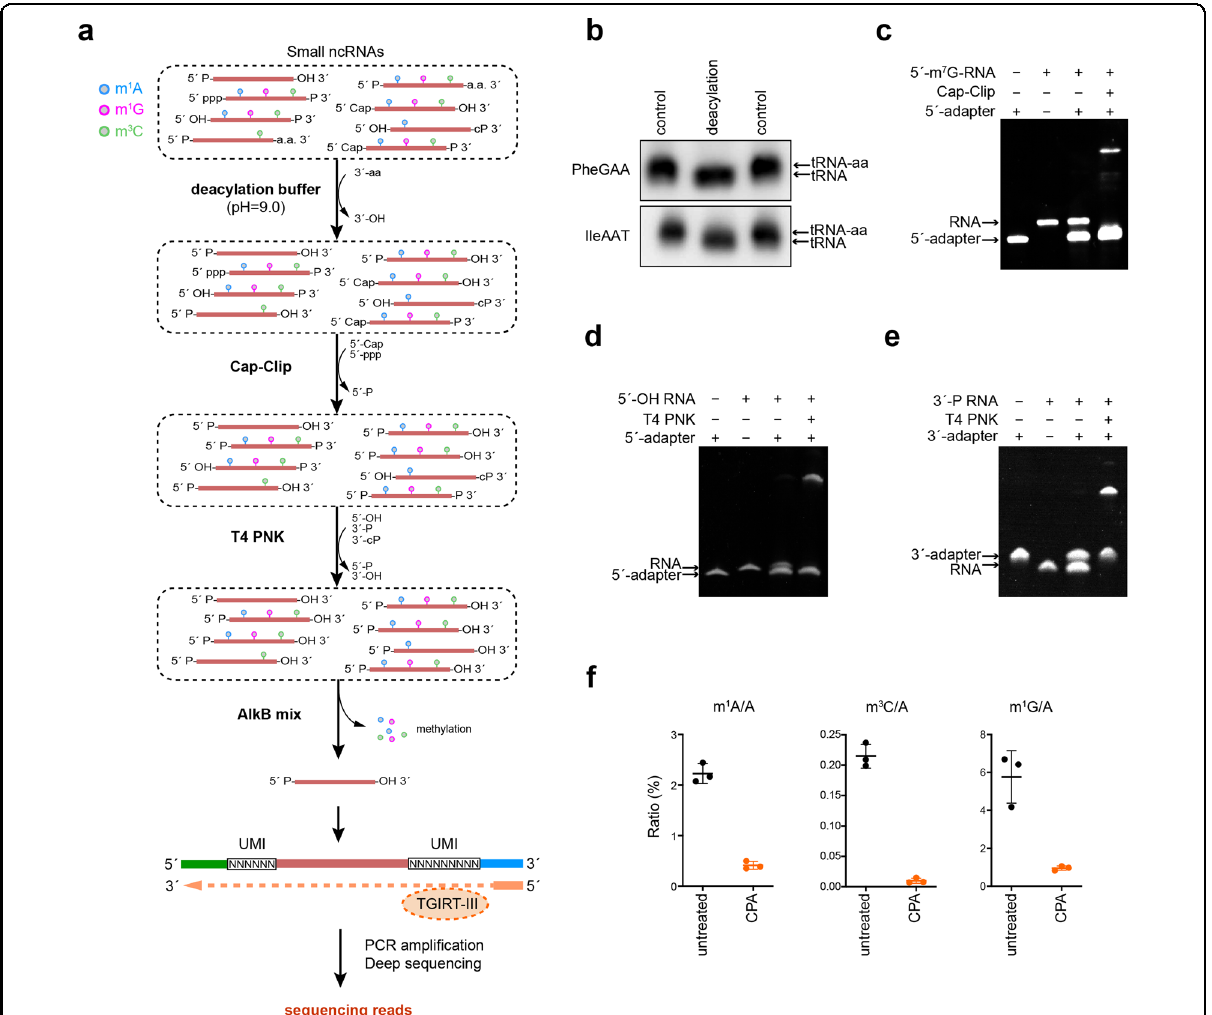
Fig. 1 CPA-seq. a The work fl ow of sRNA library preparation for CPA-seq. Puri fi ed small RNAs are incubated in deacylation buffer to remove 3 ′ - aminoacyl (3 ′ -aa), treated with Cap-Clip to remove 5 ′ m 7 G and m 3 G caps, then treated with T4 PNK to convert 5 ′ -OH to 5 ′ -P, and to convert 3 ′ -P and 3 ′ -cP to 3 ′ -OH, followed by treatment with a mix of AlkB and AlkB(D135S) to remove methylations in m 1 G, m 3 C, and m 1 A. The pretreated small RNAs were ligated with 3 ′ and 5 ′ adapters, reverse transcribed by TGIRT-III, and then PCR ampli fi ed for sequencing. b Northern blotting of RNA samples from HEK293T with/without treatment of deacylation buffer. c Cap-Clip treated synthetic 5 ′ -m 7 G-RNA (31 nt) was ligated with a 5 ′ -adapter (26 nt). d T4 PNK-treated synthetic 5 ′ -OH RNA (27 nt) was ligated with a 5 ′ -adapter (26 nt). e T4 PNK-treated synthetic 3 ′ -P RNA (27 nt) was ligated with 3 ′ - adapter (29 nt). f LC-MS/MS analysis showed that sequential treatments with deacylation buffer, Cap-Clip, T4 PNK, and AlkB mix (CPA) ef fi ciently removed methylations in m 1 G, m 3 C, and m 1 A of small RNAs extracted from HEK293T cells ( n =